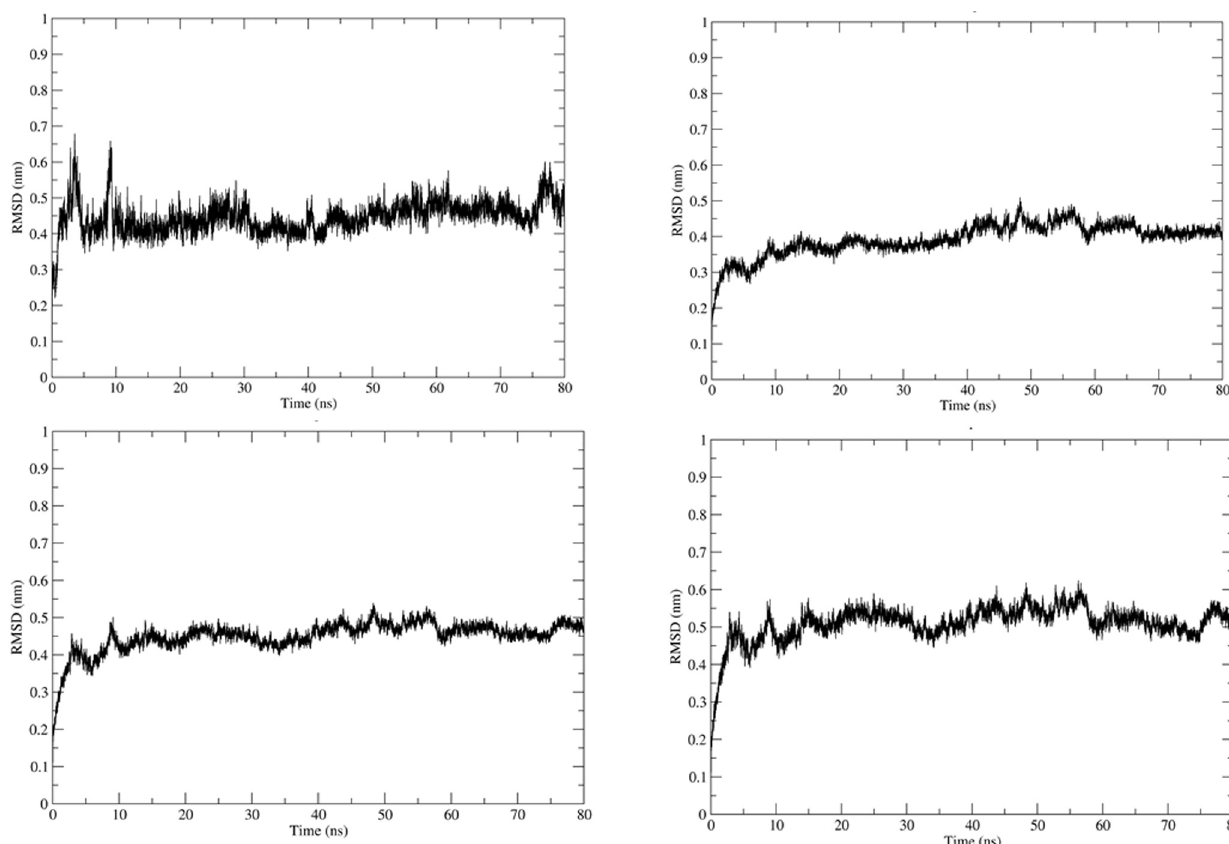
Fig 3. (a) RMSD of Peptide7 in the complex. (b) RMSD plot of SARS-CoV-2 RBD in the complex. (c) RMSD plot of peptide7-SARS CoV-2 RBD (d) Interface of Peptide 7 and SARS-CoV-2 in the complex.